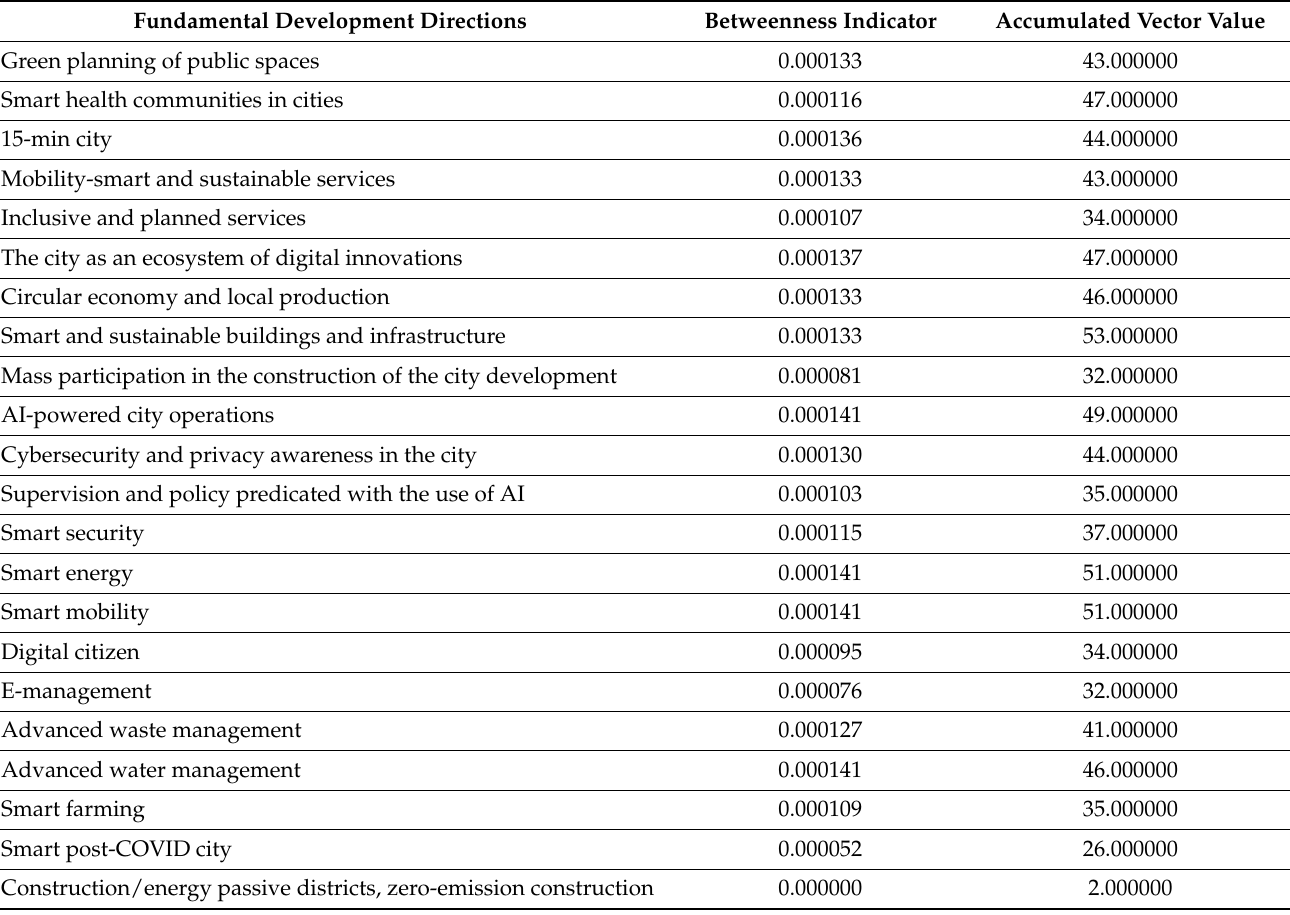
Table A7. List of scoring of smart city fundamental development directions in Poland based on expert opinion. Source: Own study.